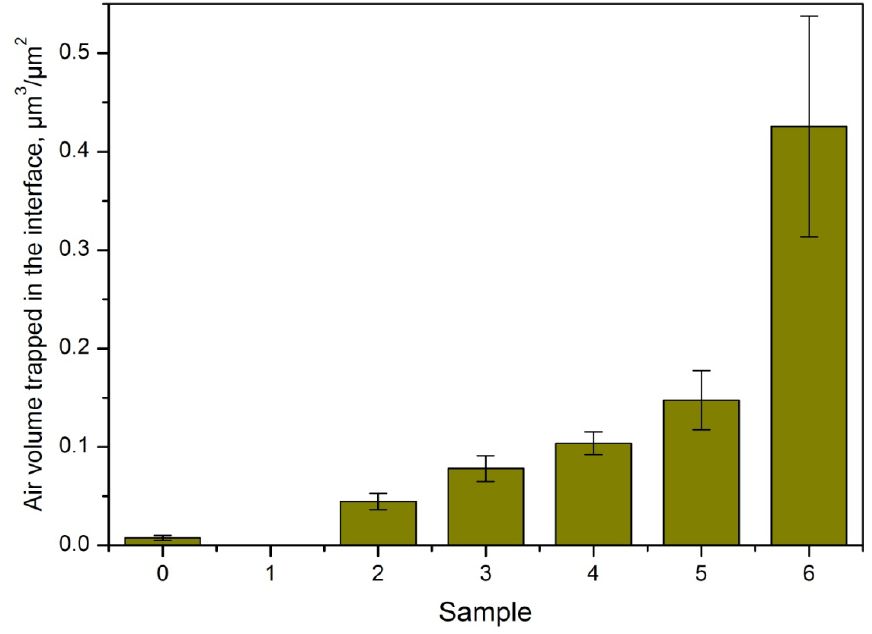
Figure 13. Calculated air volume trapped in the interface stainless steel-water. Errors are the standard deviations.